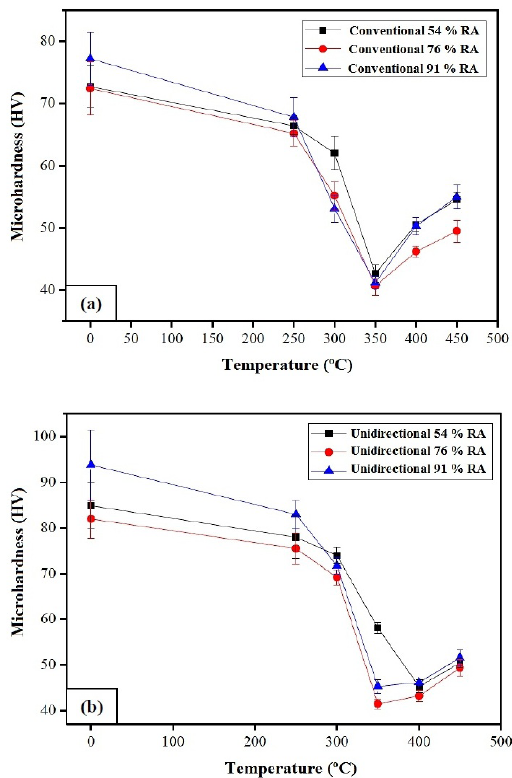
Figure 13. Microhardness of the Al4.5wt%Cu alloy after 54, 76 and 91% of RA solidified (a) Conventionally (b) Unidirectionally. precipitates in the Al4.5wt%Cu alloy. Table 2. Density of CuAl 2